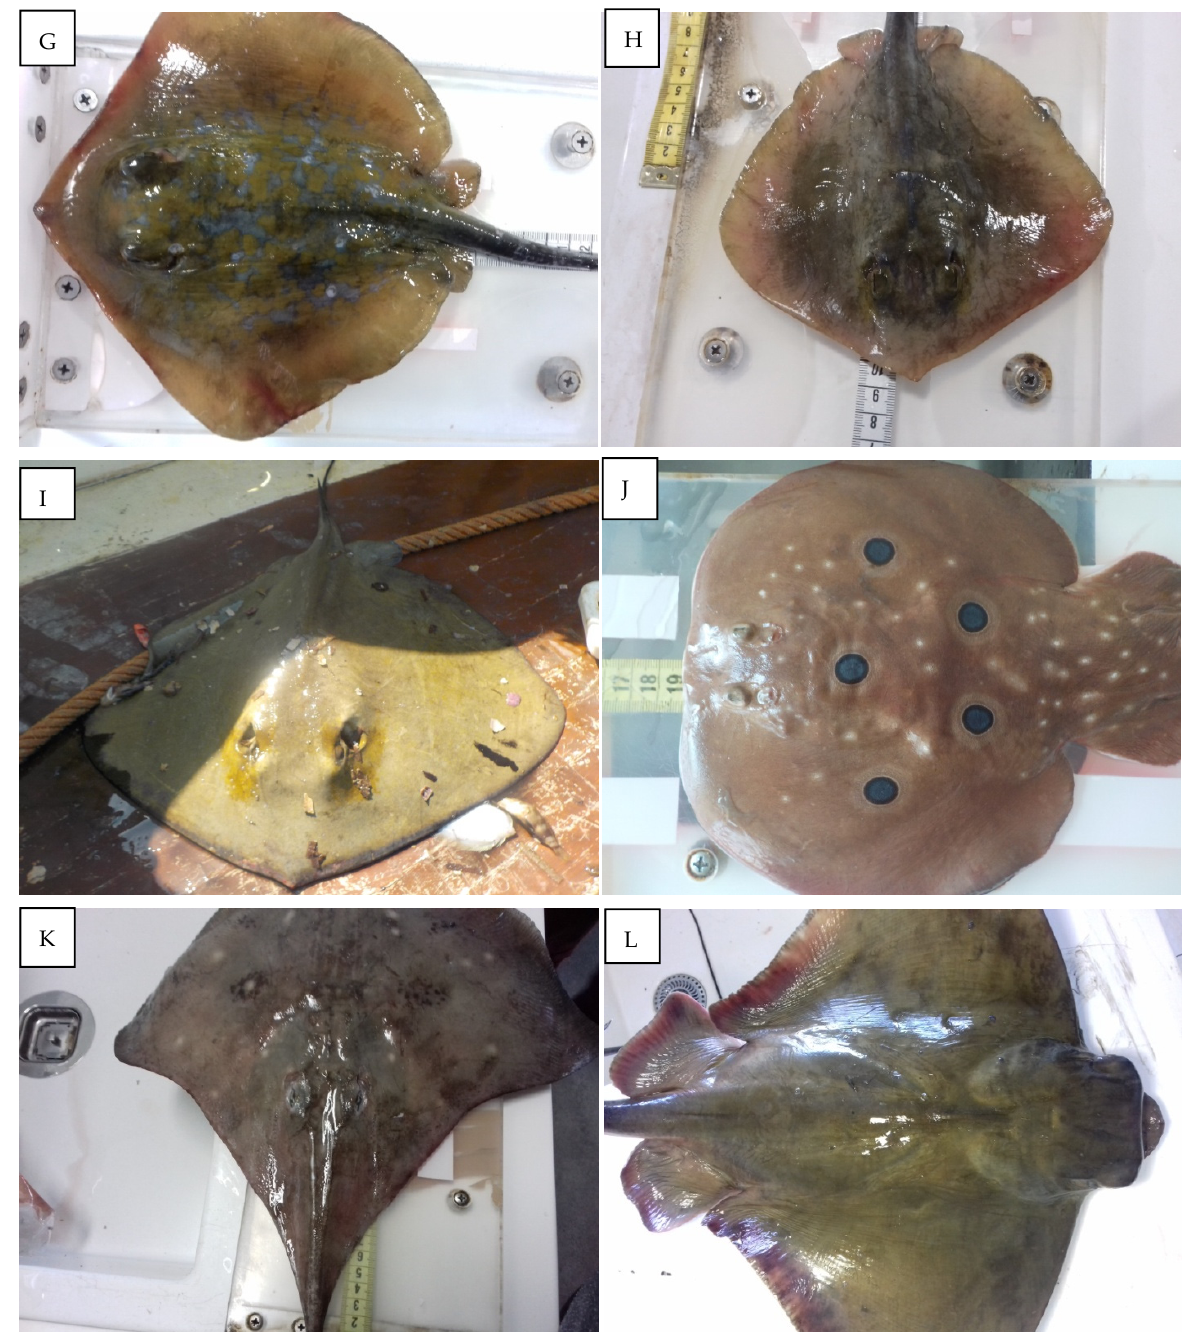
Figure 2. Skates and rays caught in bottom trawling surveys (MEDITS) and in gillnets in the eastern Ionian and Aegean Seas for the period 2017–2020: ( A ) Raja asterias , ( B ) Raja brachyura , ( C ) Raja clavata , ( D ) Raja miraletus , ( E ) Raja polystigma , ( F ) Leucoraja naevus , ( G ) Dasyatis marmorata , ( H ) Dasyatis tortonesei , ( I ) Dasyatis pastinaca , ( J ) Torpedo torpedo , ( K ) Dipturus oxyrinchus , ( L ) Myliobatis aquila (photos: A. Chatzispyrou).